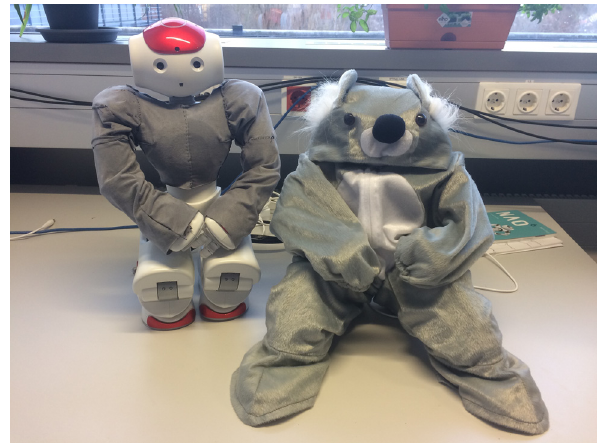
Figure 3: A photograph of the prototype fabric - based tactile sensor for a robot companion that was shown to participants.